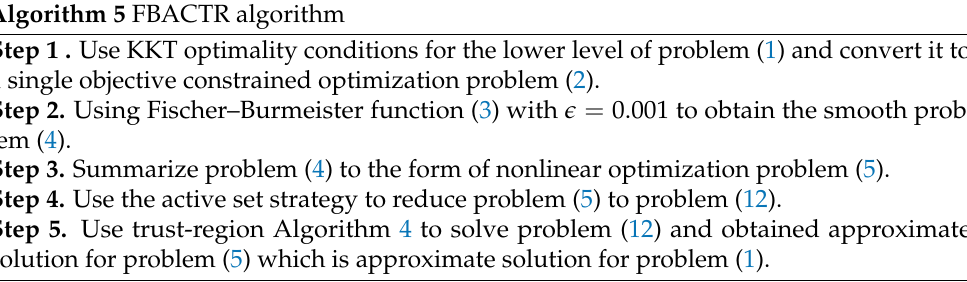
Algorithm 5 FBACTR